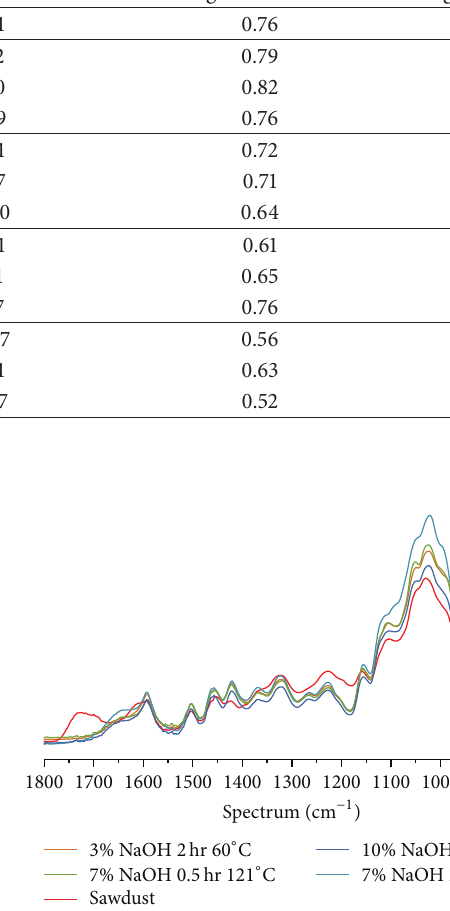
Figure 1: FTIR analysis of a verity of NaOH pretreated sawdust between 800 and 1800 cm −1 .